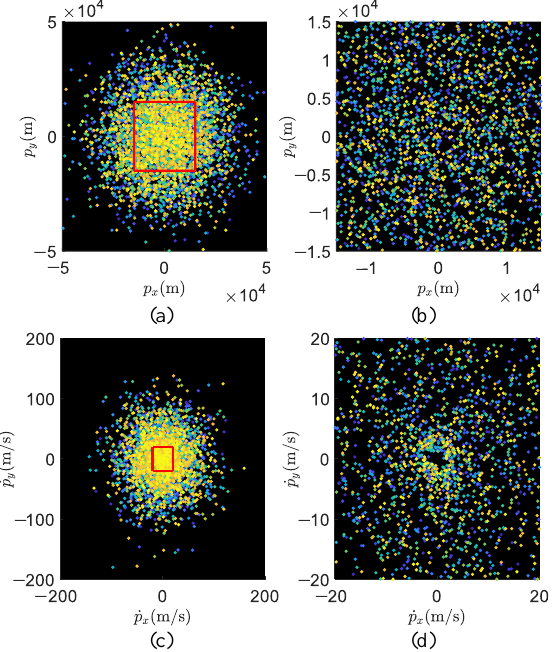
Figure 3. Results of the A-R method: ( a , b ) sample positions; ( c , d ) sample